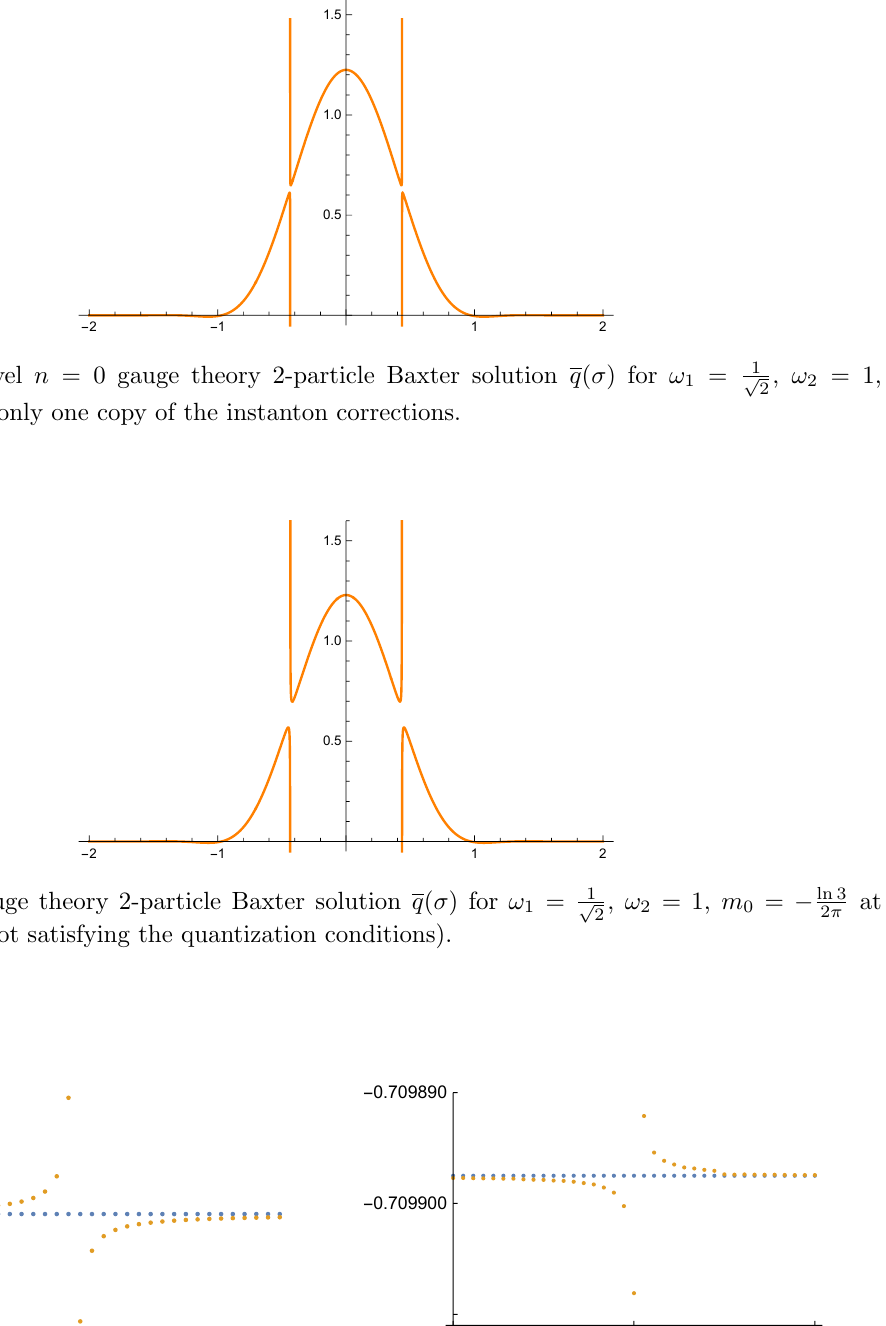
Figure 19. Level n = 1 numerical (blue dots) and gauge theory (orange dots) 2-particle Baxter solution q ( (cid:27) ) for ! 1 = 2 (cid:0) 1 4 , ! 2 = 2 1 4 , m 0 = 0 near (cid:27) = a (1) = 2. Left: 3-instanton results; right: 4-instanton results.